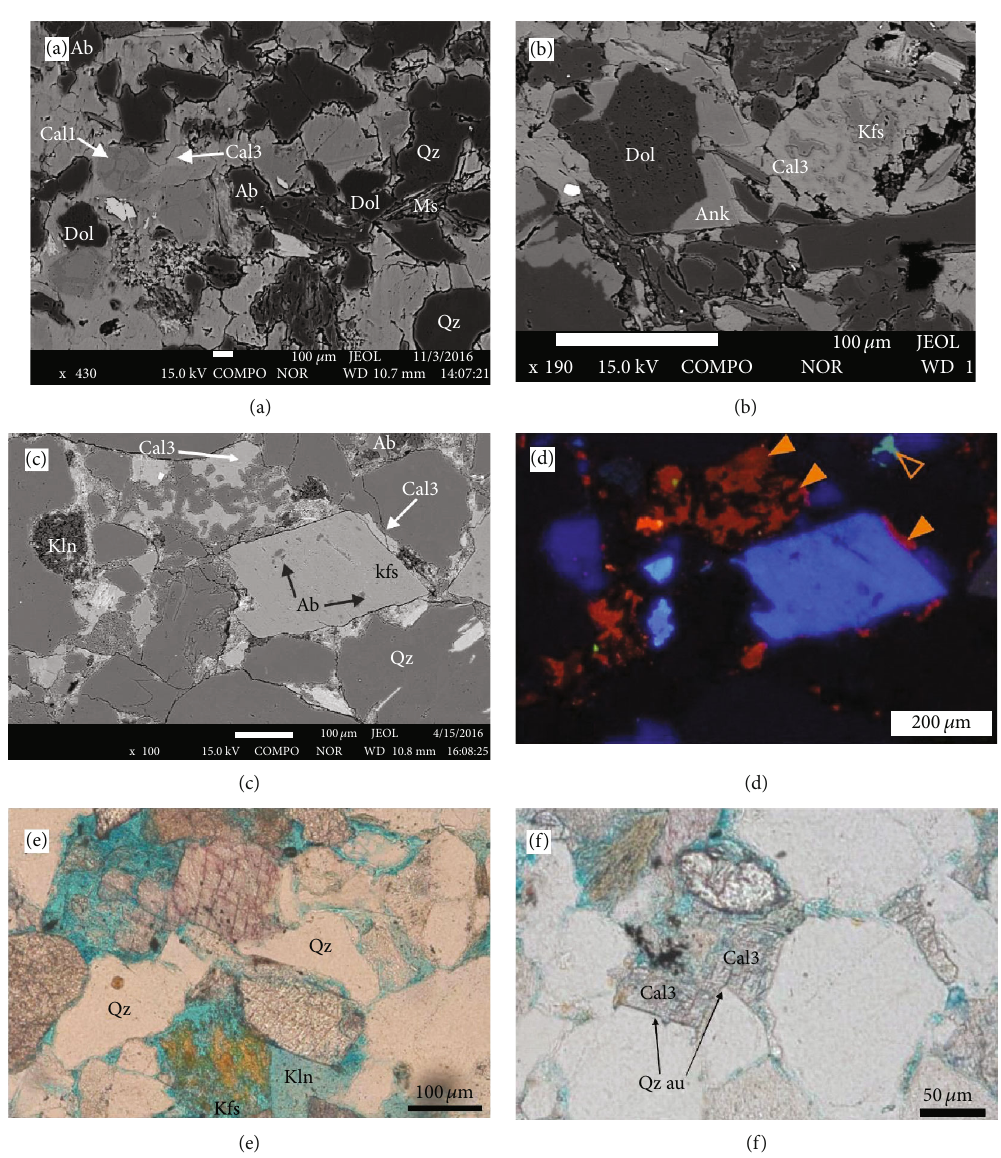
Figure 6: SEM-BSE images, photomicrographs, and CL image showing diagenetic components.(a) Fine-grained sandstones are characterized by concavo-convex grain contacts. Calcite (Cal1) crystals exhibit a faint crosspattern that resembles coccolith morphology. Large mottles of calcite (Cal3) include replacive and cement phases. Microcrystalline quartz cement occurs on quartz grains, well Mcs1, 4060 m, Endr ő d Fm. (b) Ankerite cement crystals on dolomite grain. Replacive calcite (Cal3) includes the small remnants of detrital K-feldspar, well M7, 4103 m, Szolnok Fm. (c) Sandstones of the Szolnok Formation are characterized by linear grain contacts. Diagenetic minerals consist of replacive and cement calcite (Cal3), albite and kaolinite, well M7, 3410 m, Szolnok Fm. (d) CL image of the fi eld of view shown in (c). Detrital K-feldspar of pale blue luminescent includes nonluminescent diagenetic albite. Detrital albite of greenish blue fl uorescent color (empty arrow) is present among kaolinite. Postcompactional calcite (Cal3) exhibits dull red luminescent color ( fi lled arrows), well M7, 3410m, Szolnok Fm. (e) Vuggy porosity (blue resin) includes secondary intragranular pores, which are typical in calcite (stained pink) and K-feldspar (stained yellow) and secondary, dissolution-enlarged intergranular pores, which are characterized between framework grains. Kaolinite occurs next to K-feldspar, well K1, 3020 m, Algy ő Fm. (f) Quartz with straight crystal face indicates authigenic overgrowth cement